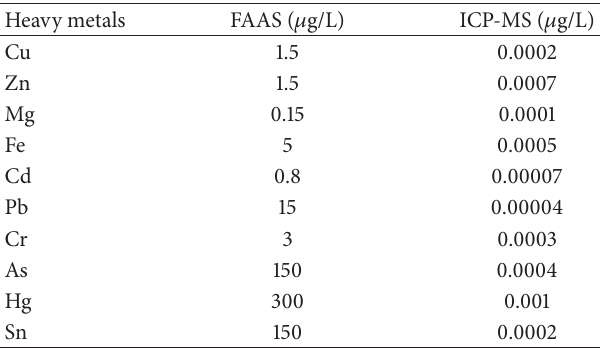
Table 5: Comparison of detection limits of selected heavy metals using FAAS and ICP-MS